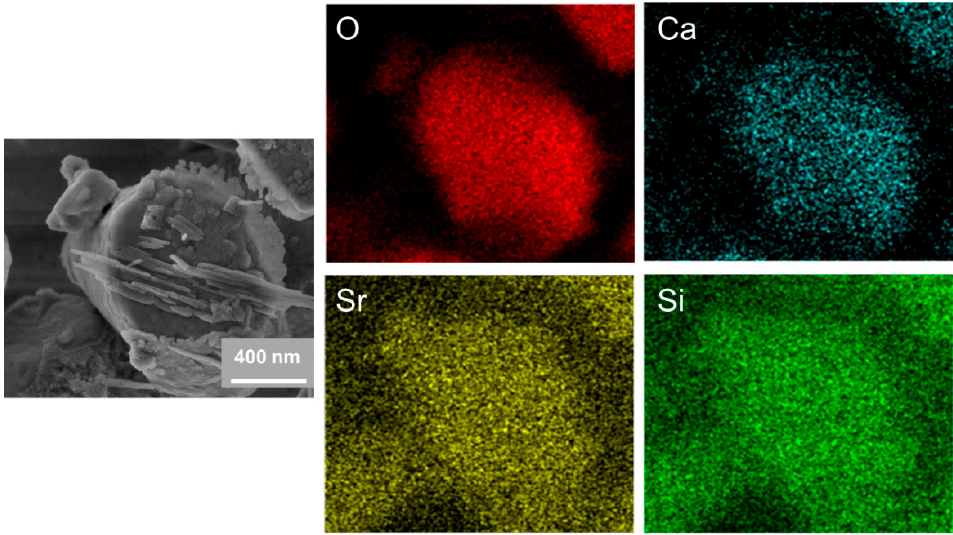
Figure 2. SEM images of C2S and Sr-C2S powders: ( a ) C2S; ( b ) Sr1-C2S; ( c ) Sr5-C2S; ( d ) Sr10-C2S.